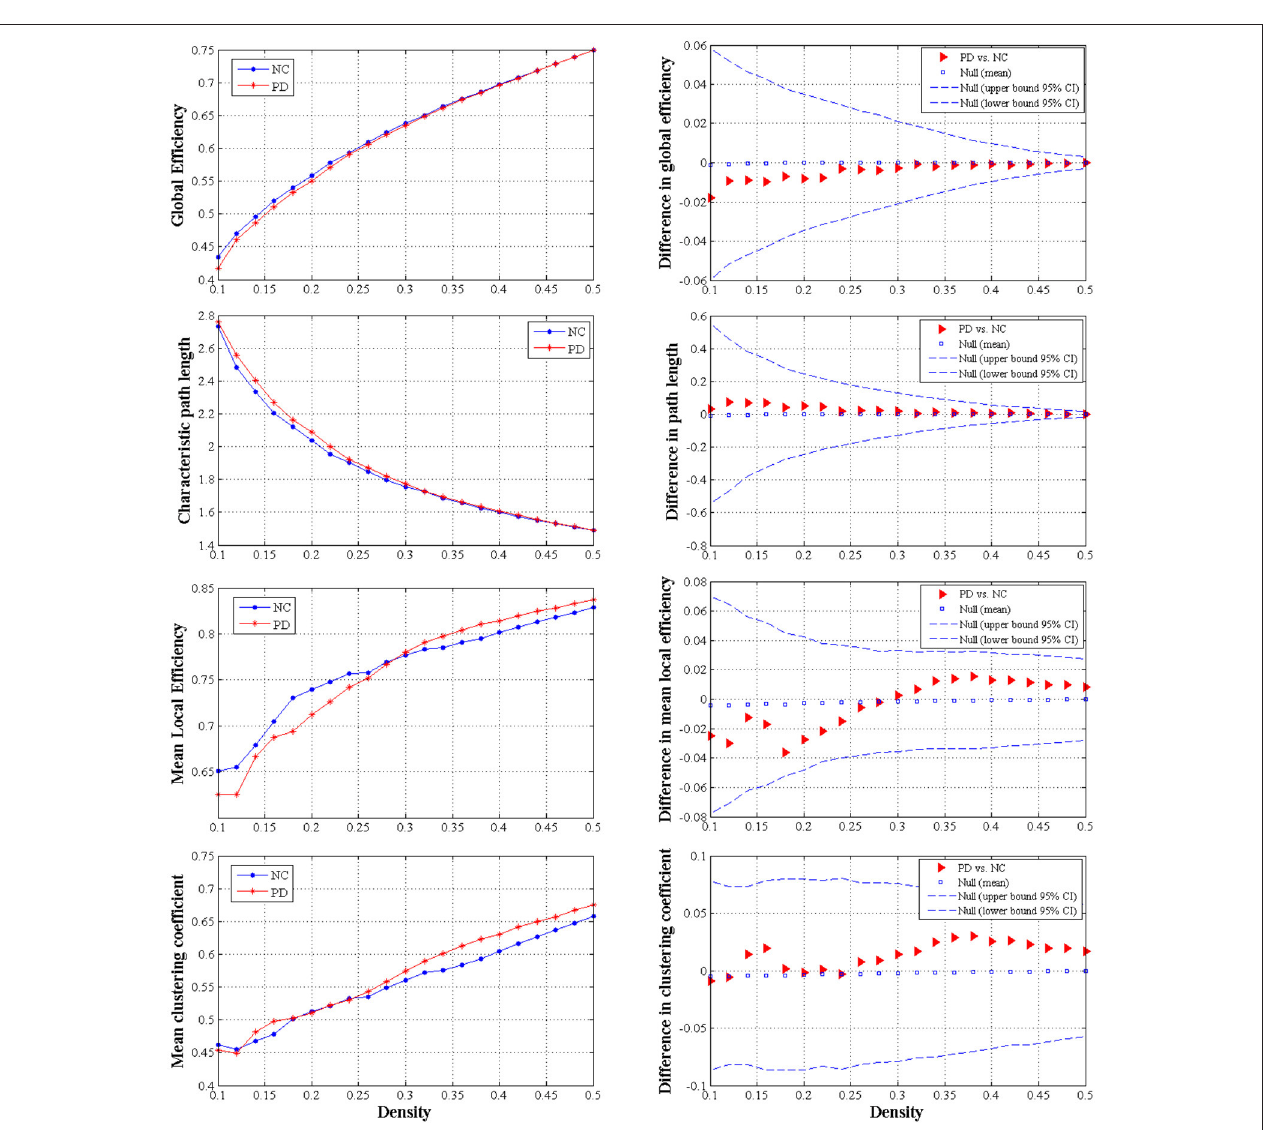
FIGURE 4 | The distributions (left column) and intergroup differences (right column) of global measures including global efficiency, characteristic path length, mean local efficiency and mean clustering coefficient in/between normal controls and PD patients with hemiparkinsonism. The upper and lower 95% confidence intervals were shown with dotted line in the right column. No significant difference was observed between